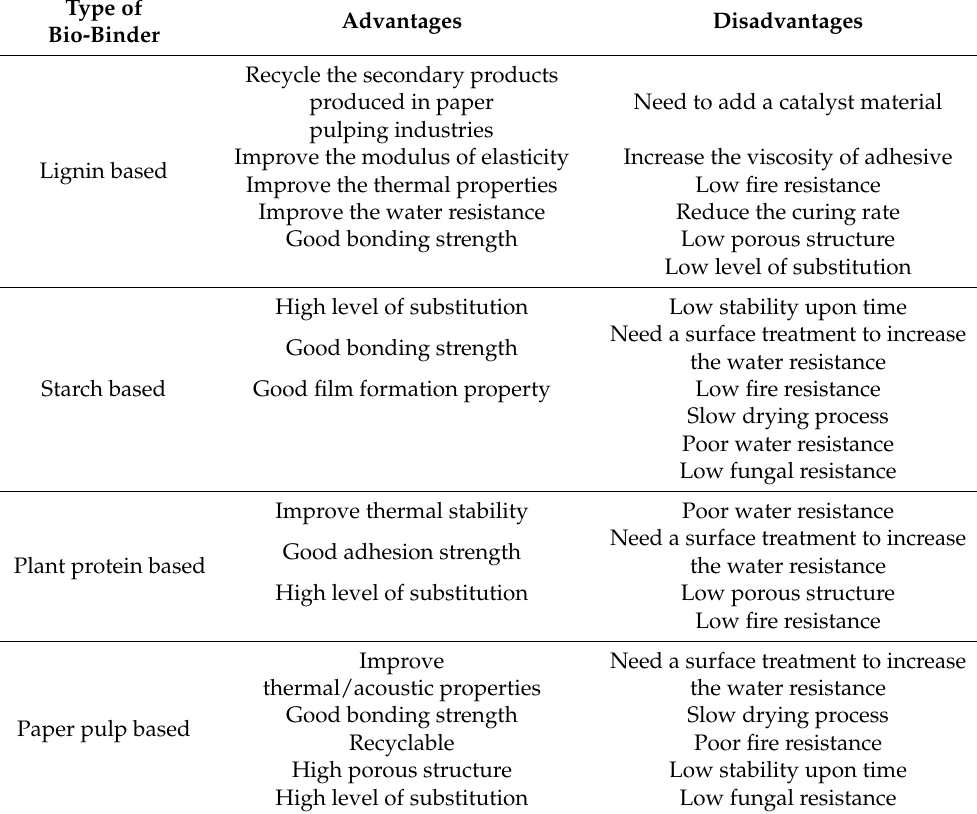
Table 3. Advantages and disadvantages of bio-binder for stalk